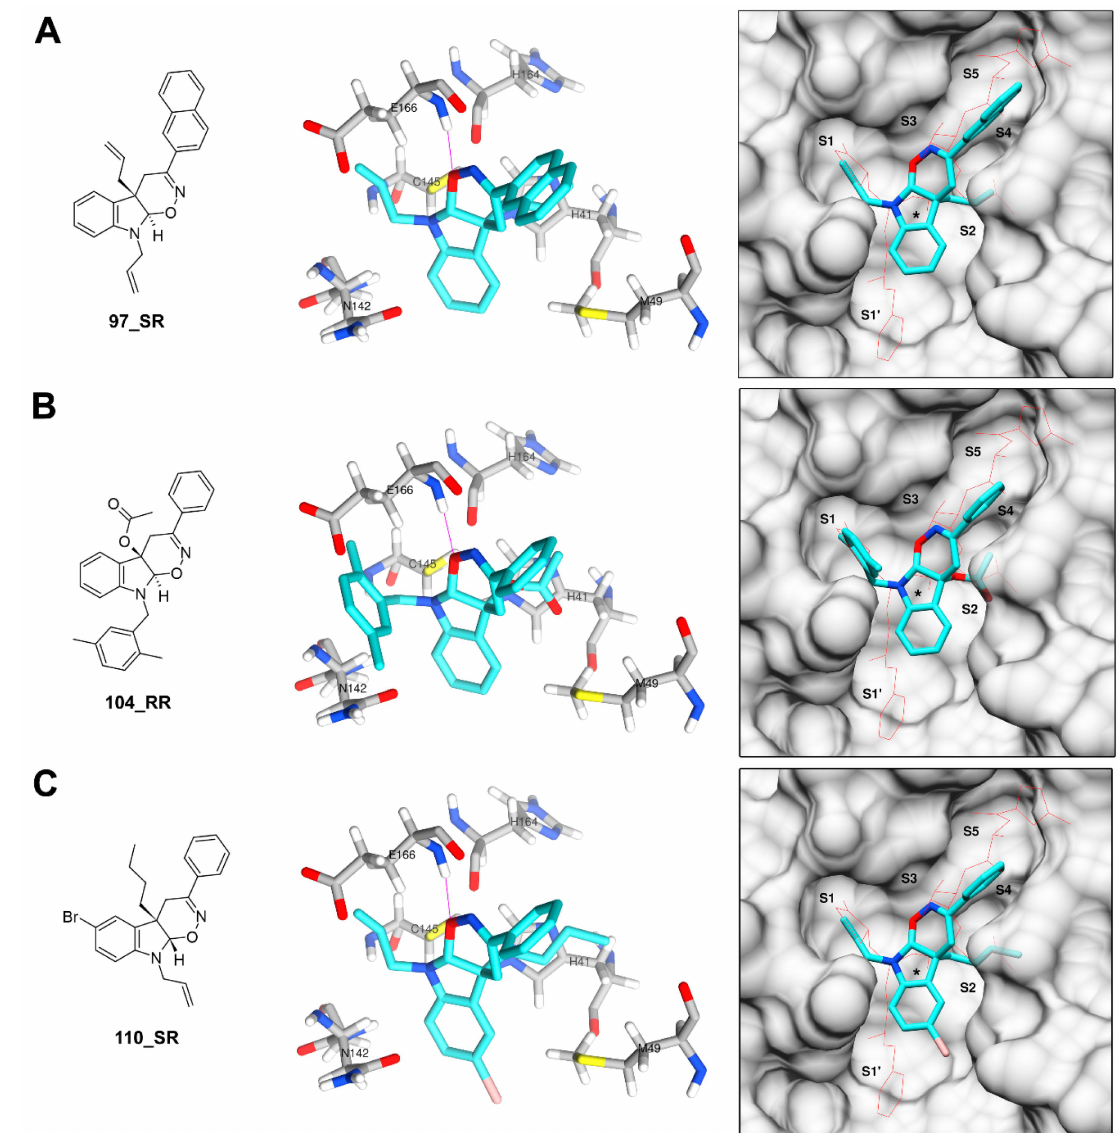
Figure 7. Docking poses predicted for stereoisomers 97_RR ( A ), 104_RR ( B ) and 110_SR ( C ). These stereoisomers are colored in cyan with hydrogen bonds represented by violet lines. The orientation of the N3 inhibitor in surface representations is indicated by a red wire and the approximate position of the His41-Cys145 catalytic dyad is indicated with